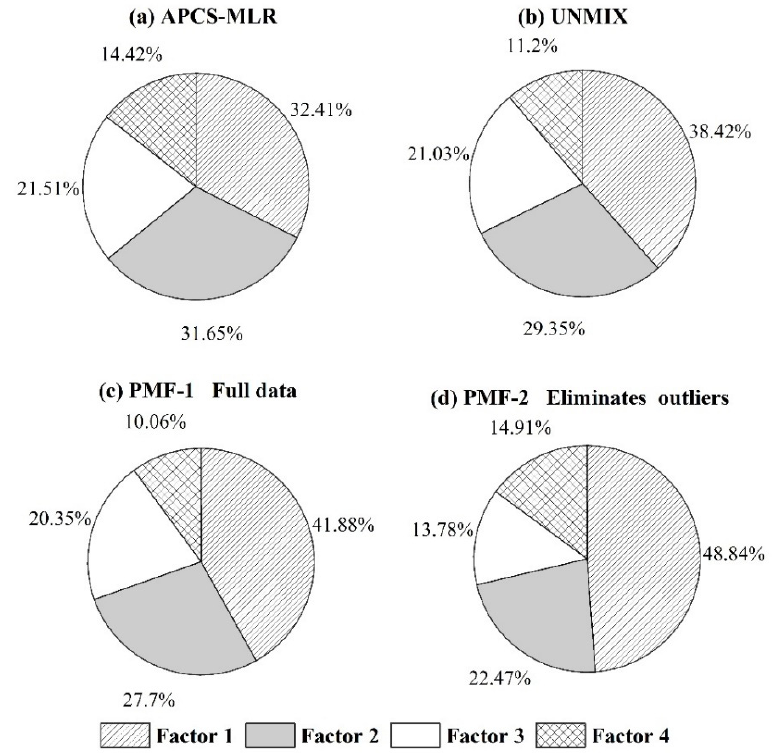
Figure 4. Factor contribution analysis of APCS-MLR, UNMIX and PMF models.